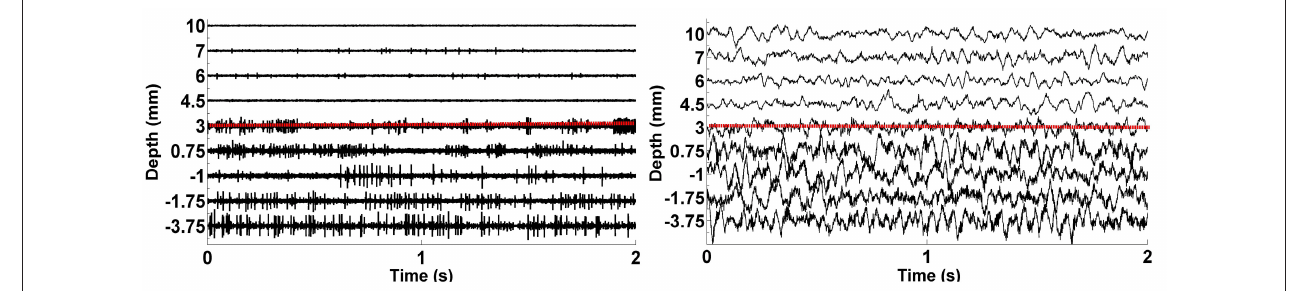
representative subject.